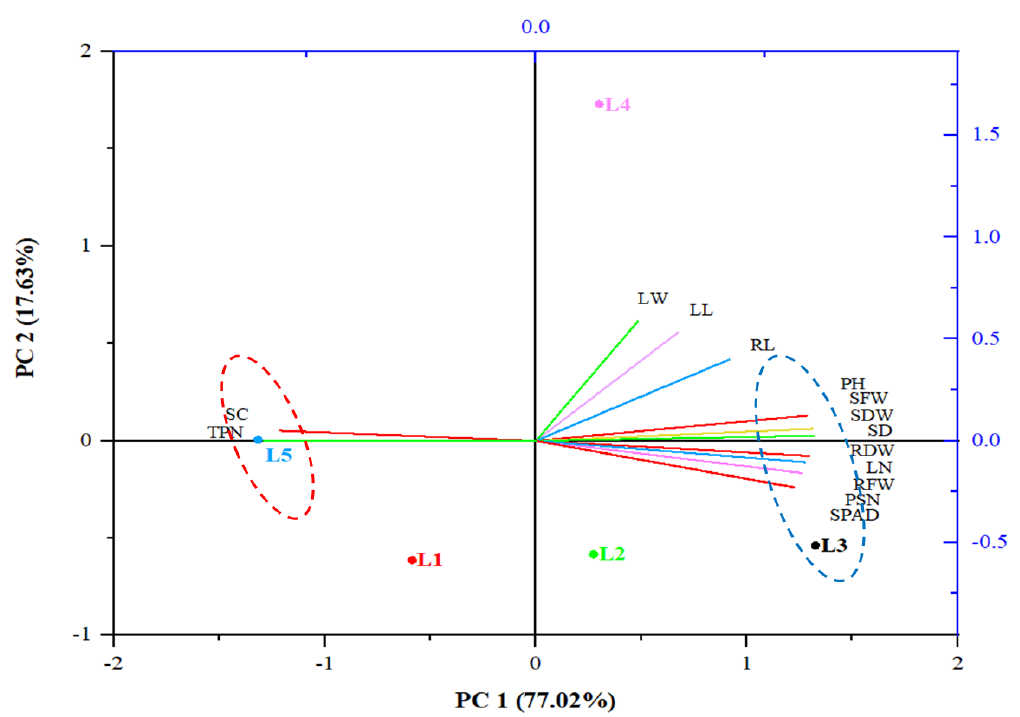
Figure 3. Principal component analysis (PCA) illustrates the variable treatment relationships among the five treatments of apple seedlings at 30 days after treatment in a controlled condition. L1, L2, L3, L4 and L5 indicate light intensity (Table 3). The lines starting from the central point of the biplots display the negative or positive associations of the different variables, and their proximity specifies the degree of correlation with specific treatment. PH-shoot height; LN-leaf number; LL-leaf length; LW-leaf width; RL-root length; SD-stem diameter; SFW-shoot fresh weight; RFW-root fresh weight; SDW-shoot dry weight; RDW-root dry weight; SPAD-SPAD value; PSN-photosynthesis rate; SC-stomatal conductance and TPN-transpiration